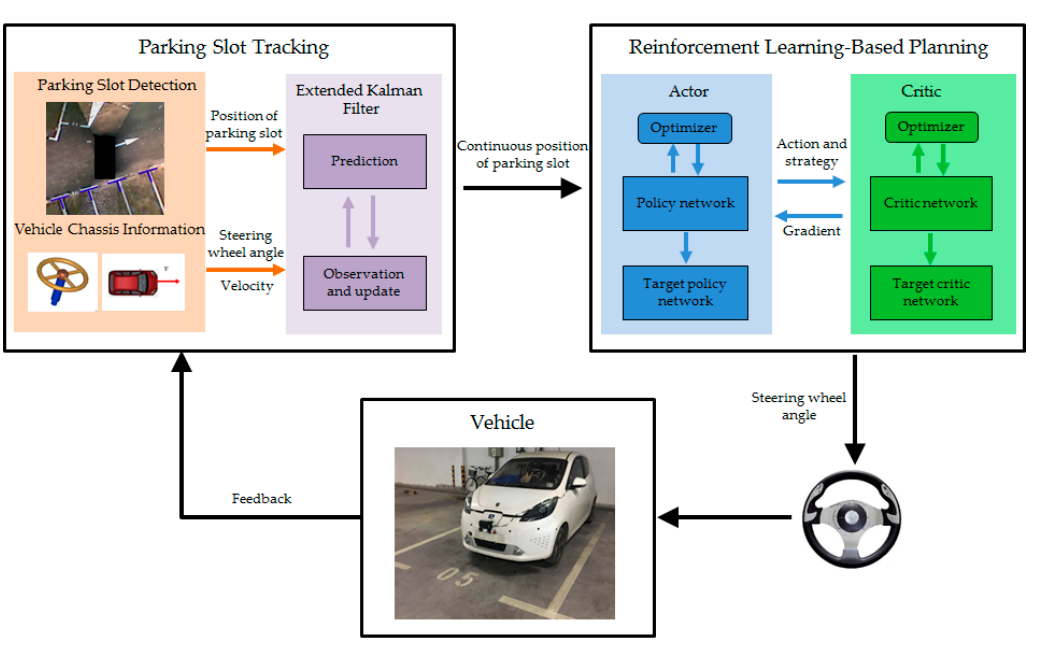
Figure 1. Overview of the reinforcement learning-based end-to-end parking method.